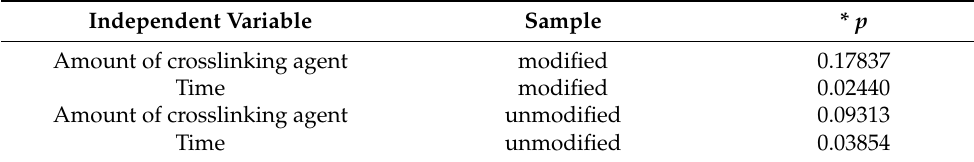
Table 3. Statistical analysis of swelling studies in hemoglobin based on the two-way analysis of variance (ANOVA) with